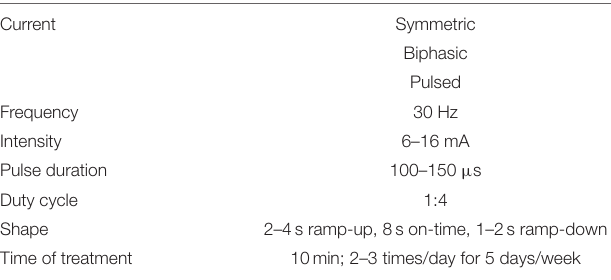
TABLE 1 | Functional Electrical Stimulation (FES)